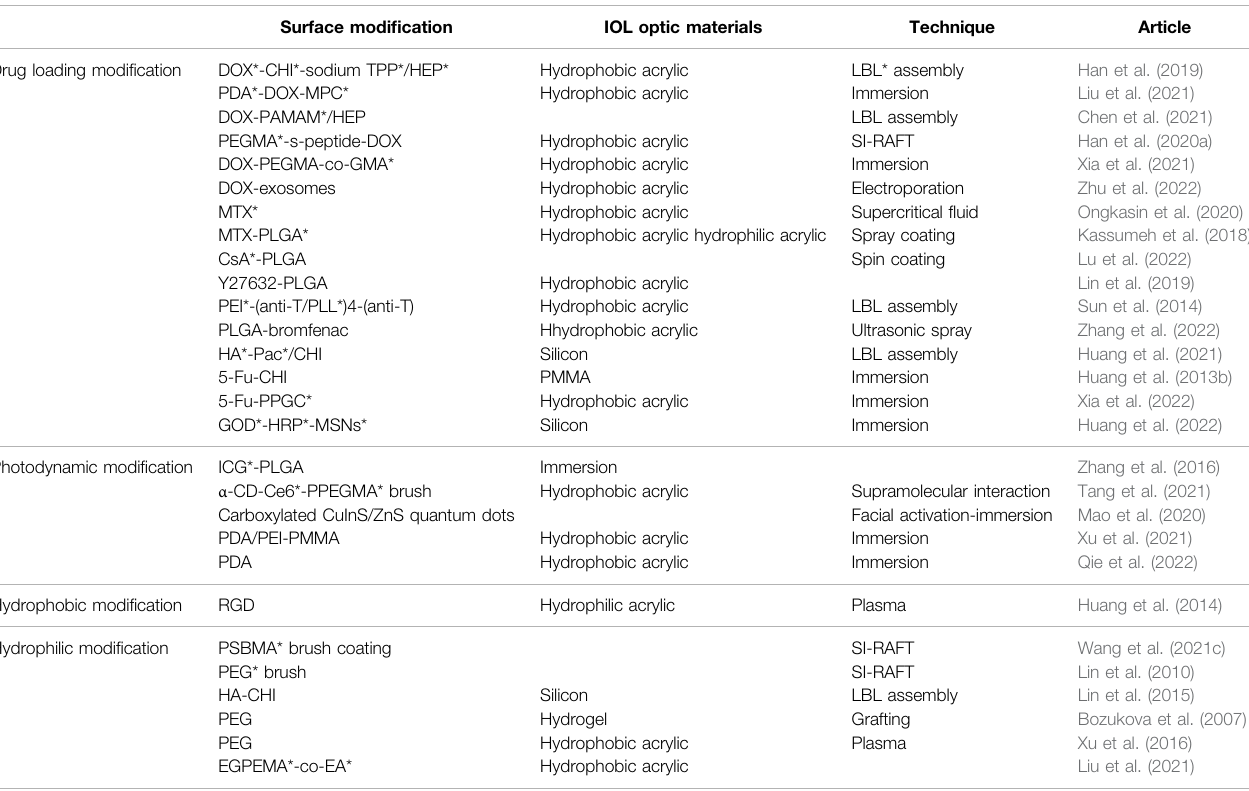
TABLE 3 | The studies on materials reducing